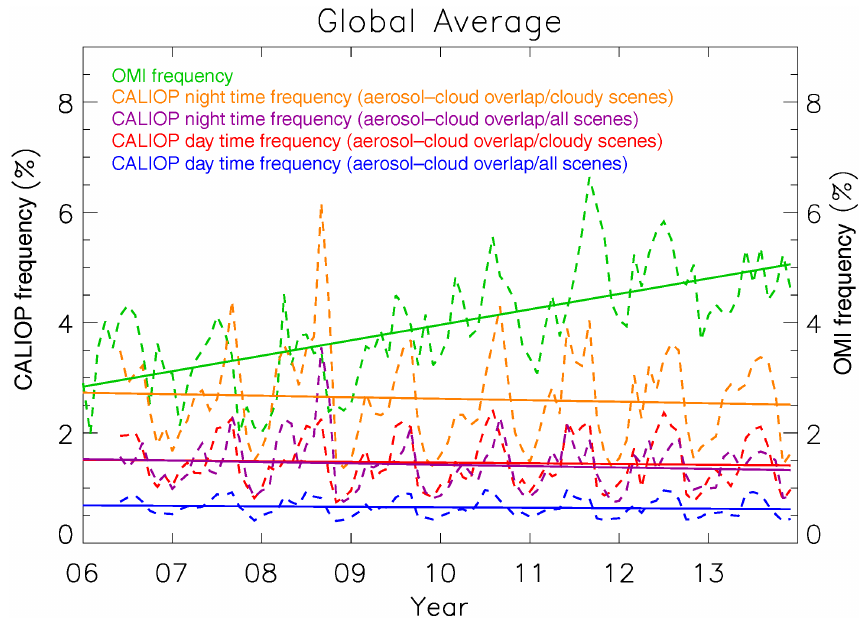
Figure 10. Monthly averaged global ACA frequencies derived using the OMI-MODIS-based method (green) as well as the CALIOP-based method as described in the text. The corresponding baseline thresholds are applied to both CALIOP and OMI data. Dashed lines represent monthly variations in ACA frequencies and the solid lines represent the yearly ACA frequency trends: OMI daytime cloudy-sky frequency is shown in green, CALIOP nighttime cloudy-sky frequency is orange, CALIOP nighttime all-sky frequency is purple, CALIOP daytime cloudy-sky frequency is red, and CALIOP daytime all-sky frequency is blue.